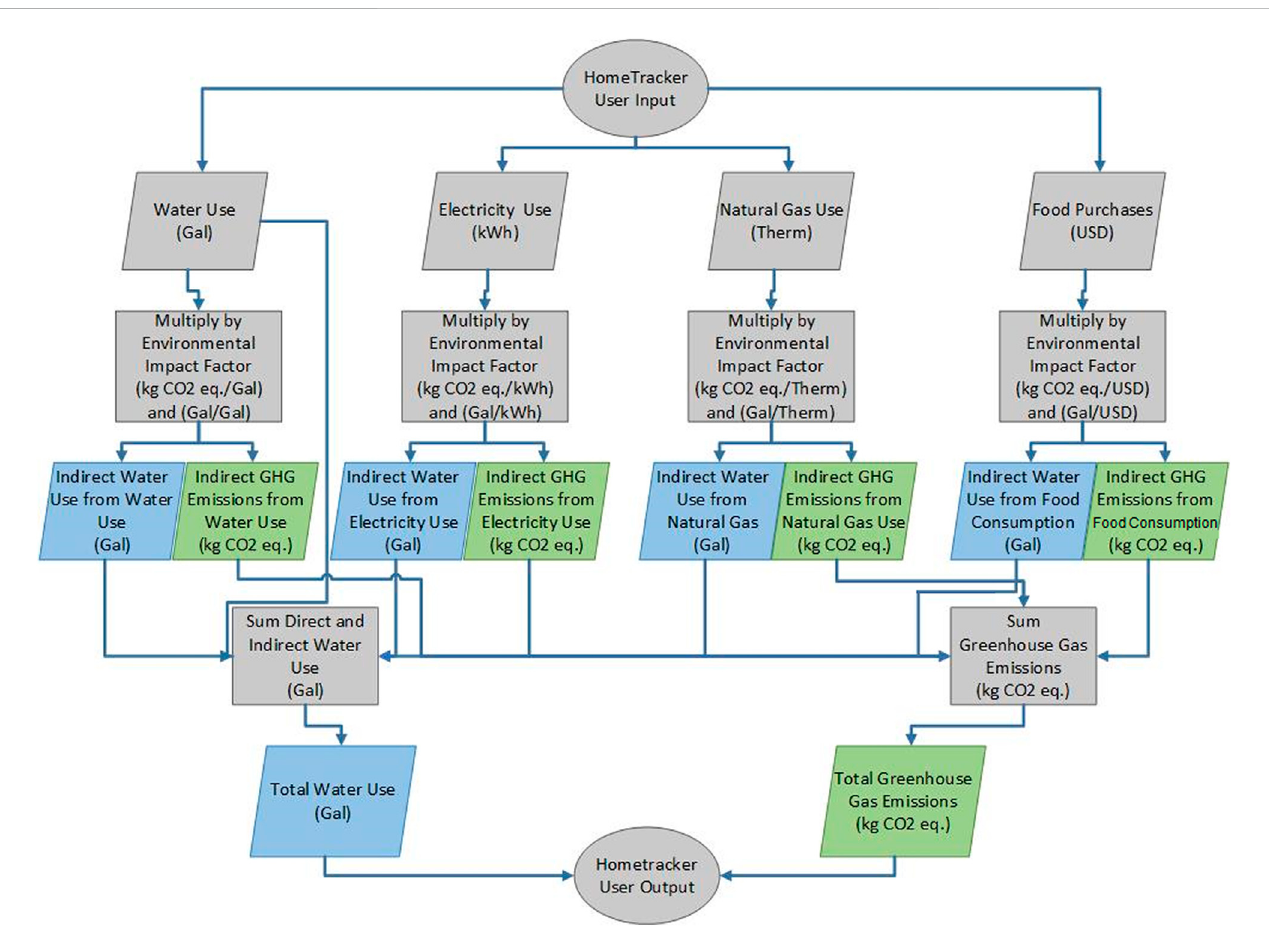
FIGURE 1 Modelstepstoconvertconsumption-baseddirectandindirectinputstoenvironmentalimpacts:wateruseingallonsandgreenhousegasemissionsinkg CO 2-